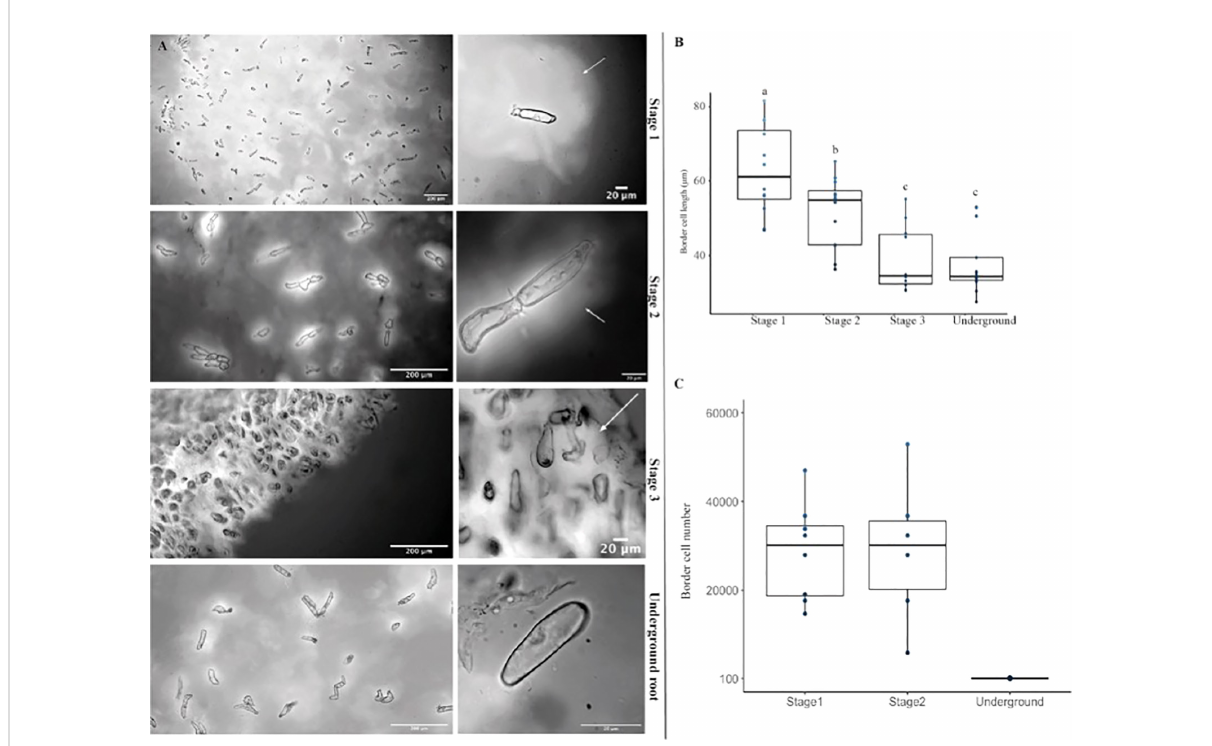
FIGURE 6 The mucilage produced in the aerial root surface is enriched in border cells, and the border cell secretes mucilage. (A) The left panel shows a general view of border cells embedded in its mucilage in stages 1, 2, and 3, and the underground root system. The right panels are magni fi ed images of a light microscope representing the shape of the Ames 19897 accession border cells (GRIN) from aerial roots and underground roots. (B) Border cell lengths from aerial root stages 1 and 2 are larger than stage 3 and underground border cells. (C) Stages 1 and 2 have more border cells than stage 3. Error bars represent the standard deviation between biological replicates counted in two independent experiments. Analysis of variance (ANOVA) was performed on border cell length, and number values, and signi fi cance difference represents “ a ” p < 0.05; “ b ” p<0.01, “ c ”